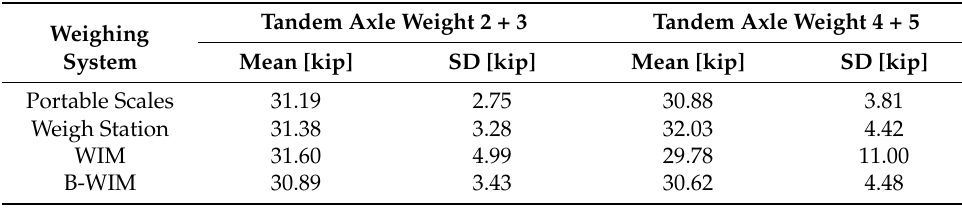
Table 5. Statistical parameters of tandem axle weights for all weighing systems.